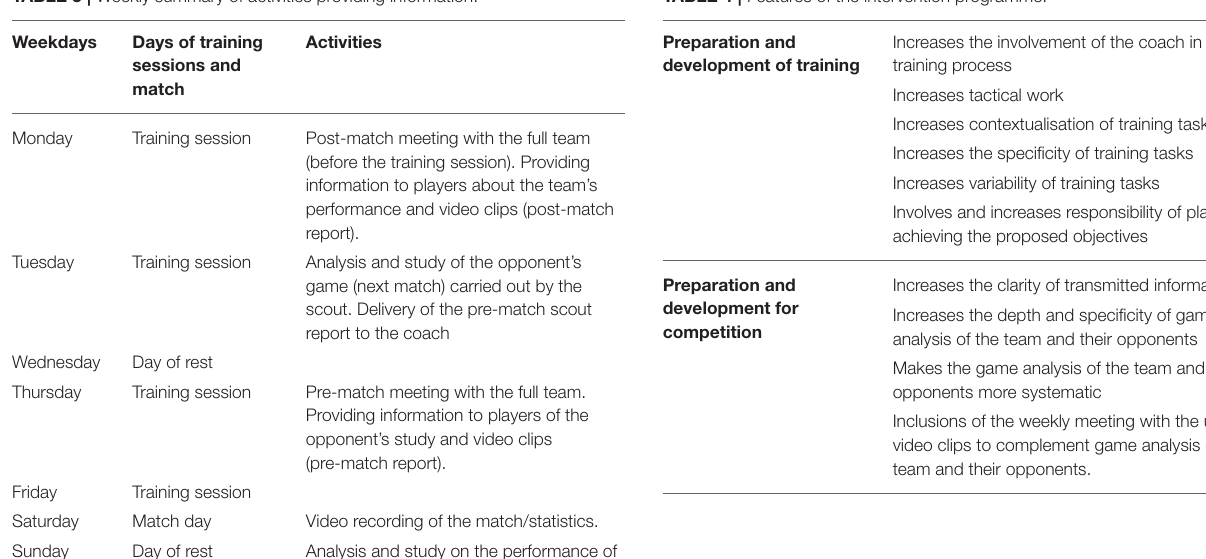
TABLE 3 | Weekly summary of activities providing information. TABLE 4 | Features of the intervention